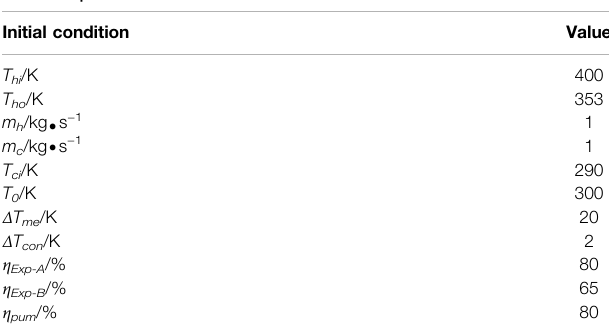
TABLE 1 | Initial conditions used for